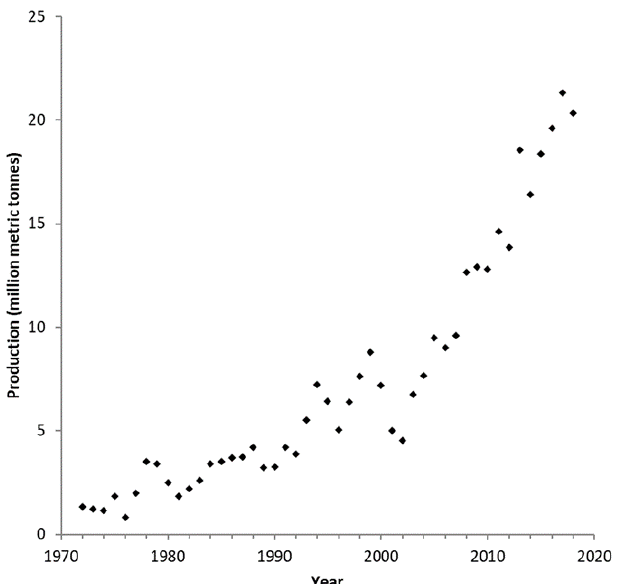
Figure 4. Canola production in Canada has increased steadily since the introduction of the first low-erucic acid, low-glucosinolate canola cultivar ‘Tower’ in 1974 (Source: Statistics Canada. Table 32-10-0359-01, accessed on 1 September 2021).